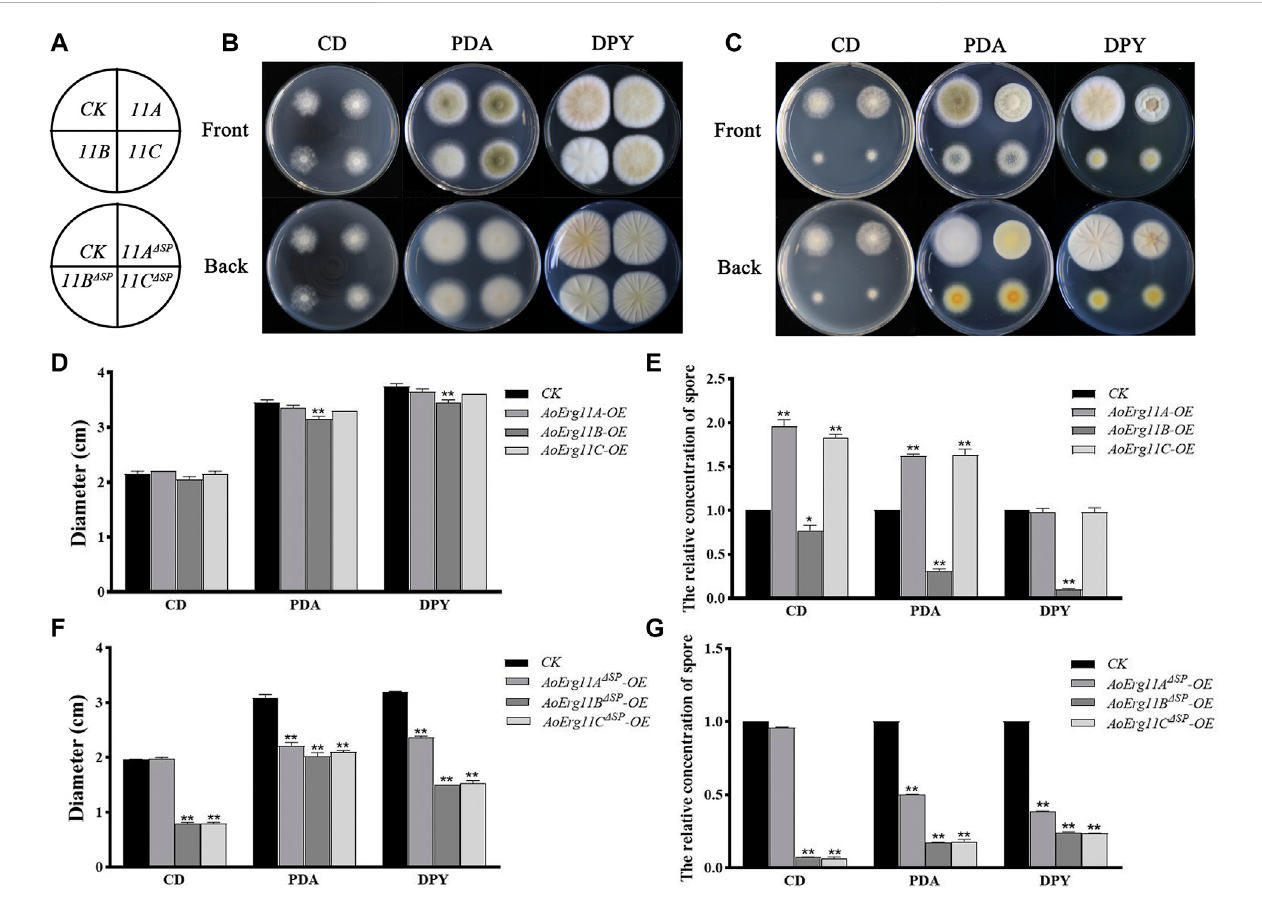
FIGURE 5 Phenotypes of AoErg11s and AoErg11 Δ SP s overexpression strains. (A) The schematic of Figure B (upper) and Figure C (lower). (B,C) Colony morphologies of CK (wild-type A. oryzae transformed pEX2B vector), AoErg11s and AoErg11 Δ SP s overexpression strains on CD, PDA and DPY medium after 72 h incubation (D – G) The relative concentration of spores and colony diameter of different transgenic strain colonies. Spore suspension of identical concentrations of different A. oryzae strains were plated on CD, PDA and DPY agar medium and incubated at 30 ° C for 72 h. Values represent the mean ± SD of three independent experiments. Statistical analyses were performed by t -test of GraphPad (*, p < 0.05; **, p < 0.01). Each experimental group was compared to the corresponding